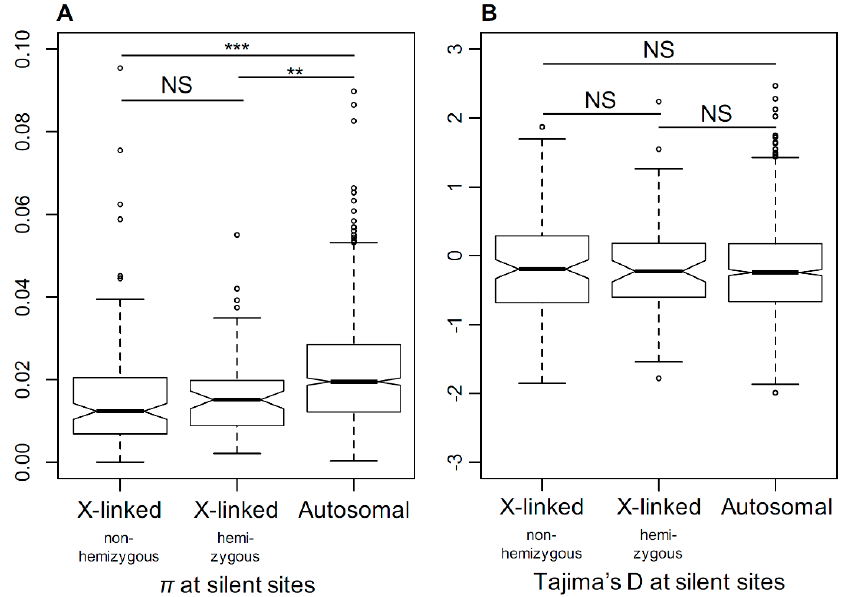
Figure 6. The comparison of silent genetic diversity in S. latifolia X-linked and autosomal genes. The comparison of silent genetic diversity ( π , panel A ) and Tajima’s D (panel B ) for X-linked and autosomal genes. The difference in nucleotide diversity ( π ) between X-linked and autosomal genes is highly significant (Student’s test, *** p < 0.001, ** p <